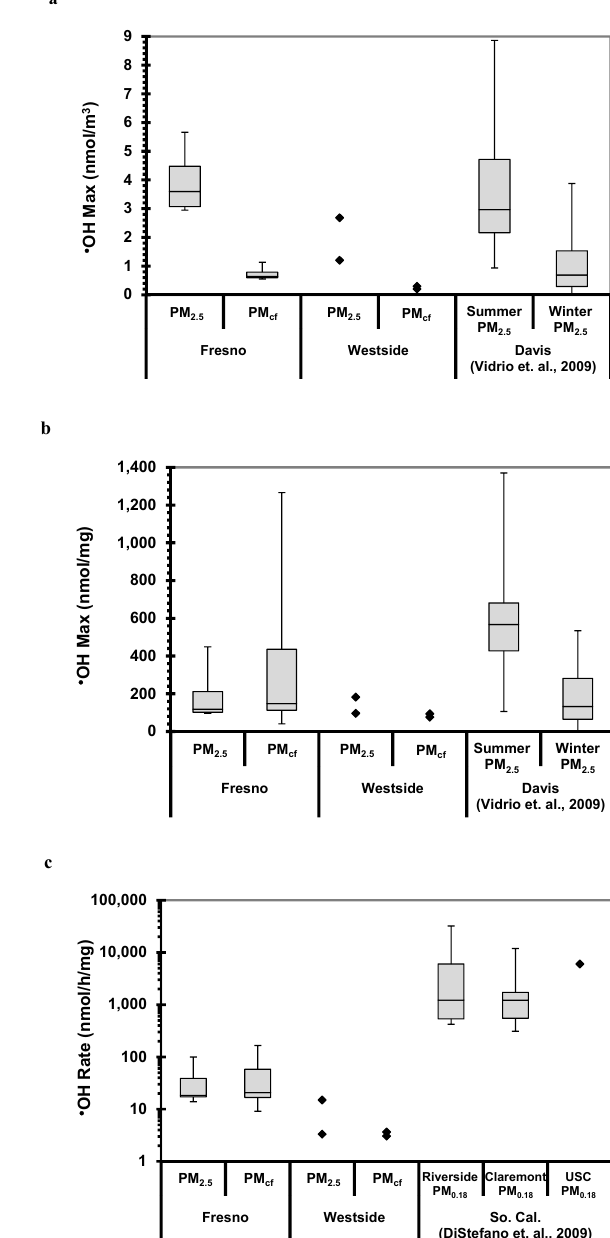
Fig. 4. Comparison of • OH generation in SJV PM with results for PM 2 . 5 from Davis, California (Vidrio et al., 2009), shown in (a) and (b) , and PM 0 . 18 from southern California (DiStefano et al., 2009), shown in (c) . The Davis PM were extracted for 24h at room tem- perature in a similar surrogate lung fluid, but with 200µM ascorbate and 300µM citrate (Vidrio et al., 2009). The southern California PM were extracted for 45min at 37 ◦ C in a pH 6.4 solution con- taining 500µM ascorbate and 500µM salicylate as the • OH probe (DiStefano et al., 2009). Each box and whisker plot shows the me- dian, upper and lower quartiles, and upper and lower